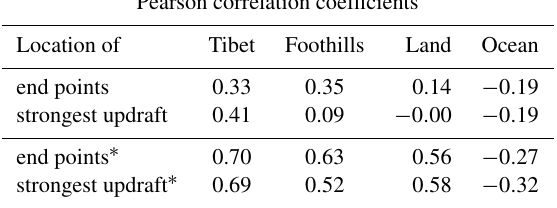
Table 5. Pearson correlation coefficients between the different re- gions (Tibet, Foothills, Land and Ocean) and the backscatter inten- sity averaged over the ATAL altitude range ((BSR 455 − 1) × 100) for the location of the end points of the trajectories (see Fig. 15) and for the location of the strongest updraft. For each region the Pear- son correlation coefficient was calculated using all measurements except the one on 12 August, when the UTLS is filled by a 5km thick cirrus cloud. Further, the Pearson correlation coefficients are also calculated, excluding in addition low statistics flights (11, 21, 23 and 26 August) for which the trajectory number is lower than 50% of the maximum number of trajectories (704) calculated on 18 August 2016 (see Fig. 14) as well as the no ATAL case on 15 August (marked by ∗